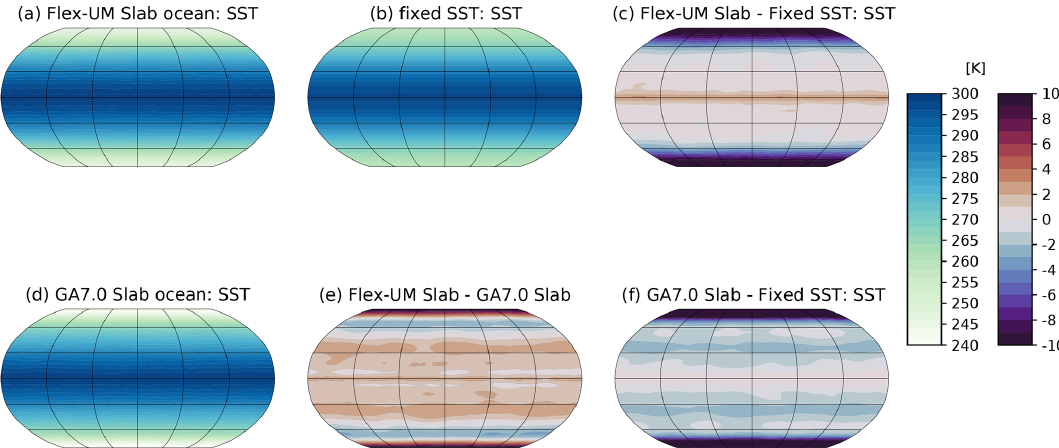
Figure 1. UM aqua-planet climatologies of SSTs (K) for (a) Flex-UM slab ocean, (b) fixed SSTs (identical for Flex-UM and GA7.0), (c) the difference between the slab-ocean and fixed-SST simulations for Flex-UM, (d) GA7.0 slab ocean, (e) the difference in the slab-ocean SSTs for Flex-UM and GA7.0, (f) the difference in the slab-ocean and fixed-SST simulations for GA7.0. The climatologies in panels (a, b, d) are plotted on the native resolution of the model. The difference plots (c, e, f) use data interpolated onto the Flex-UM grid.